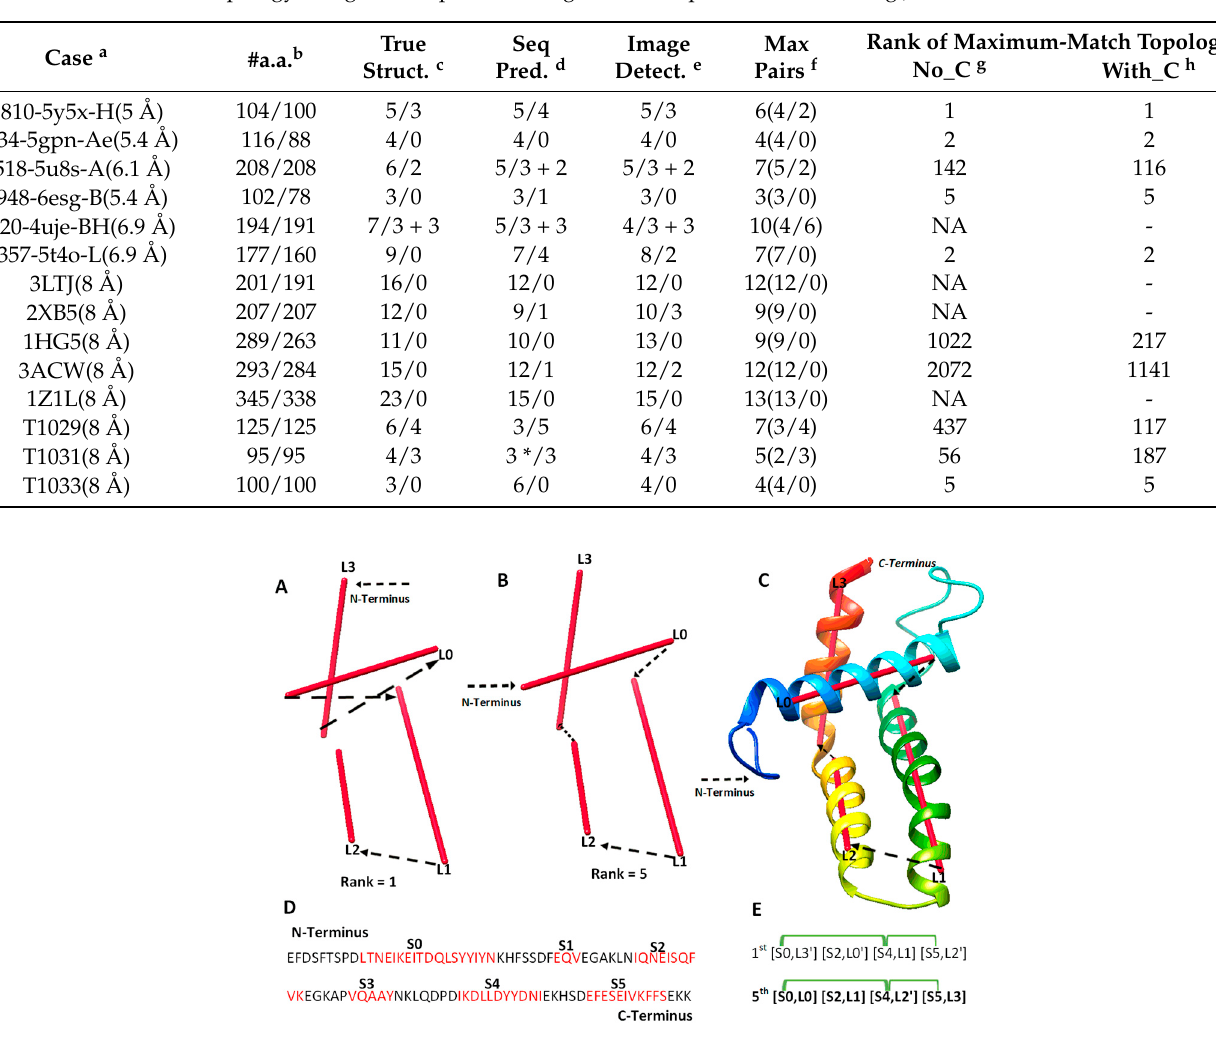
Figure 2. The maximum-match topology for case T1033. ( A ) The 1st ranked topology indicated with black arrows from the N to C terminus of the protein. The α -traces detected from the simulated density map are shown in red. ( B ) The 5th ranked topology is the maximum-match topology, similarly shown as in ( A ). ( C ) The atomic structure of T1033 (rainbow ribbon) superimposed with the 5th topology. ( D ) The amino acid sequence of protein T1033 and helices (red) predicted using JPred [30]. ( E ) Representation of the 1st and the 5th ranked topology. Correctly matched secondary structure pairs are highlighted in the maximum-match topology. Secondary structure contact pairs are marked in green for satisfaction of the distance requirement of 13 Å.